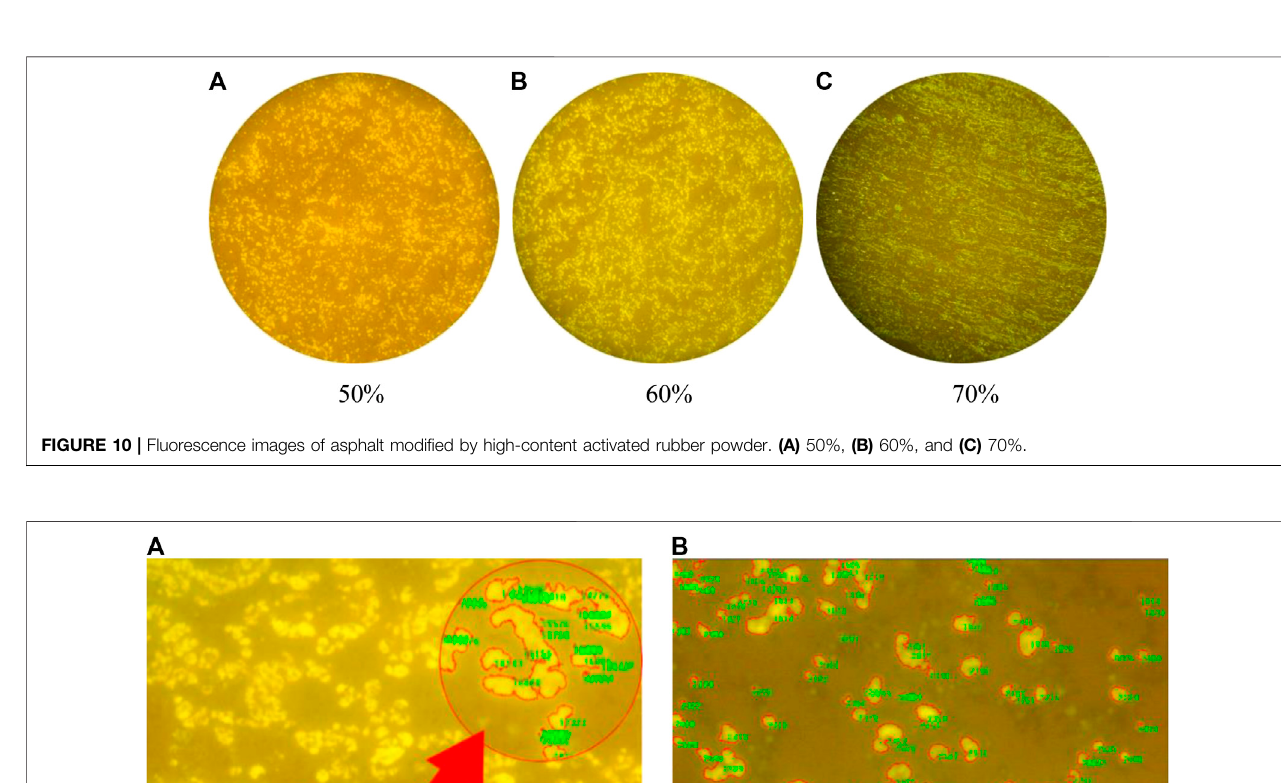
FIGURE 9 | The variation of degradation rate with the amount of rubber powder. (A) High temperature. (B) Medium temperature.